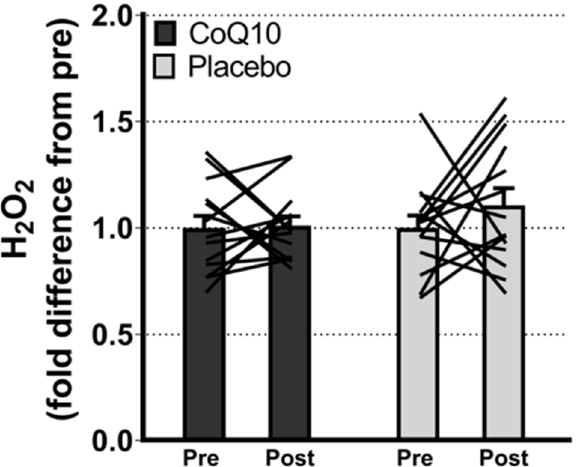
Figure 4. Maximal ROS (H 2 O 2 ) production with convergent electron flow through mitochondrial complex I and II. Data are expressed as fold difference from pre (mean ± SEM, CoQ10: 14, placebo: 14). The lines shows pre and post measurements in each individual. ROS: Reactive oxygen species. Error bars on “Pre” bars are SEM of fold difference from the mean.